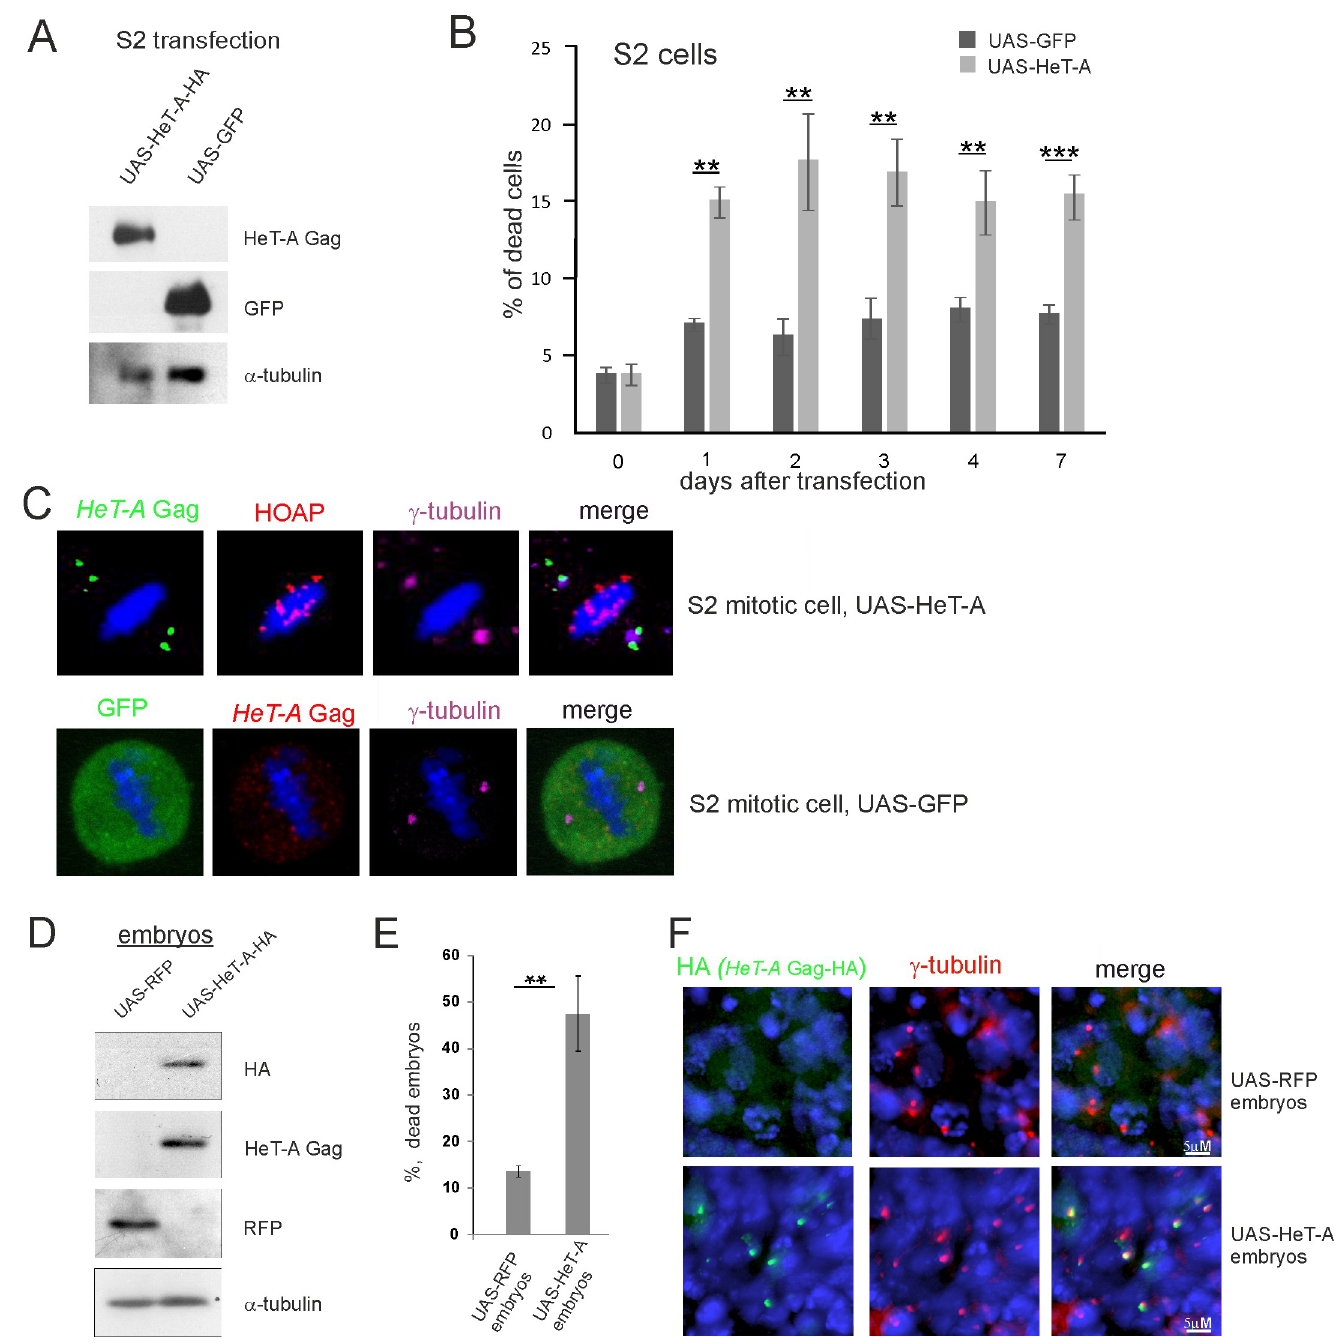
Fig 1. Induced overexpression of HeT-A in somatic cells is cytotoxic. (A) The samples of transfected S2 cells were separated by sodium dodecyl-sulfate polyacrylamide gel electrophoresis (SDS-PAGE) and analyzed by western blotting using the antibodies indicated on the right. The constructs used for transfection are indicated above the lanes. Co-transfection with pAct-GAL4 driver was used in both cases. (B) The proportion of dead cells present in the S2 cell suspension after transfection by constructs expressing HeT-A Gag or GFP. (C) HeT-A Gag (green), HOAP (red), and γ -tubulin (magenta) immunostaining was performed on S2 cells transfected with the construct expressing full-length HeT-A (upper panel). GFP (green), HeT-A Gag (red), and γ -tubulin (magenta) immunostaining was performed on S2 cells transfected with the construct expressing GFP (lower panel). Mitotic cells at metaphase are shown. DNA is stained with DAPI (blue). (D) Western blot analysis of embryonic extracts from strains expressing UAS-RFP or UAS-HeT-A-HA under the ubiquitous da GAL4 driver. The antibodies used for western blotting are indicated on the right. (E) The percentage of dead embryos laid by transgenic females expressing HeT-A Gag or RFP. (B and E) The SEM for four independent experiments was calculated. Asterisks indicate statistically significant differences ( � P < 0.05 to 0.01, �� P < 0.01 to 0.001, ��� P < 0.001, unpaired t-test). (F) HeT-A Gag-HA (green) and γ -tubulin (red) immunostaining was performed on 3–5-h-old embryos expressing HeT-A Gag-HA or RFP. DNA is stained with DAPI (blue).